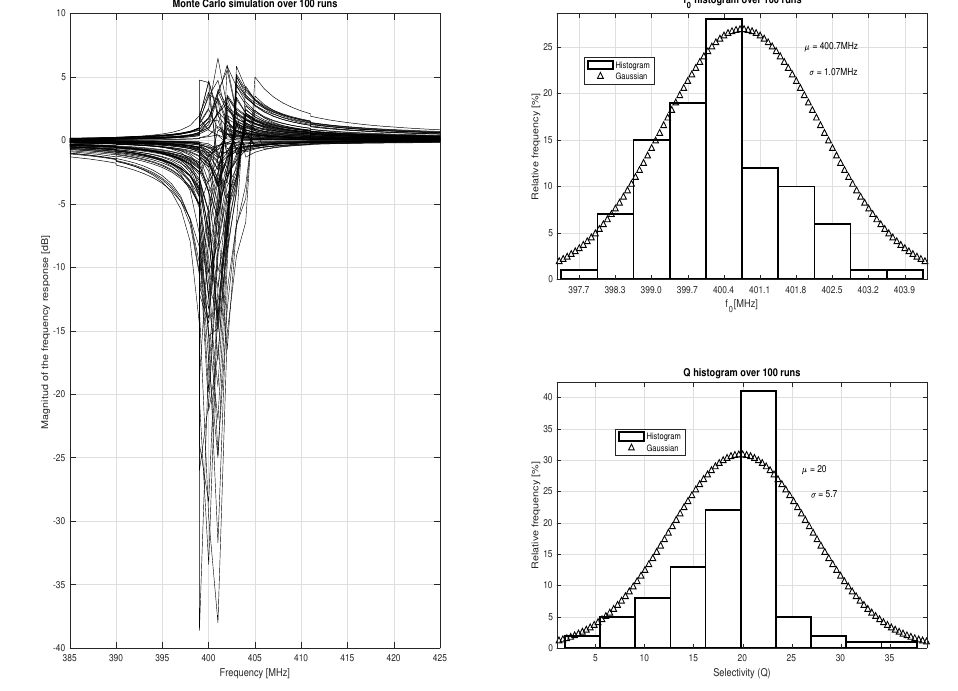
Figure 11. Monte Carlo simulation of f 0 and Q of the proposed SFG biquad. On the left, there is the frequency response of the filter. On the right, at the top, there is the f 0 histogram over 100 runs. On the right, at the bottom, there is the Q histogram over 100